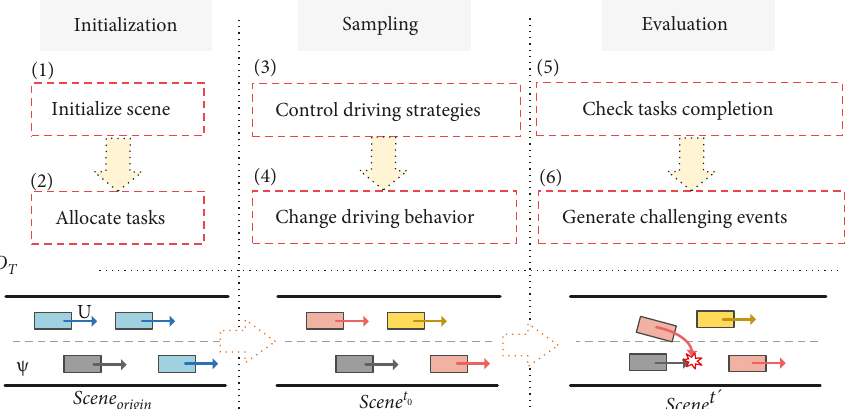
Figure 1: Testing scenario sampling process is divided into three main parts: initialization, sampling, and evaluation. The grey vehicle is the AV, while the blue vehicles are initialized to adopt no particular driving strategy. Vehicles marked red and yellow represent vehicles with aggressive and conservative driving strategies,